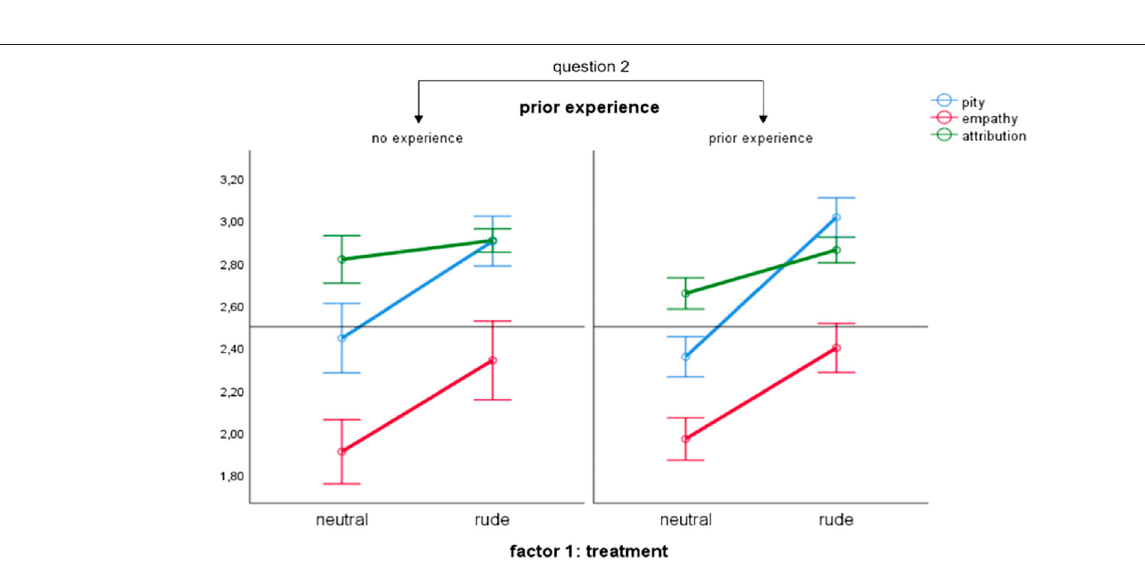
Frontiers in Computer Science |